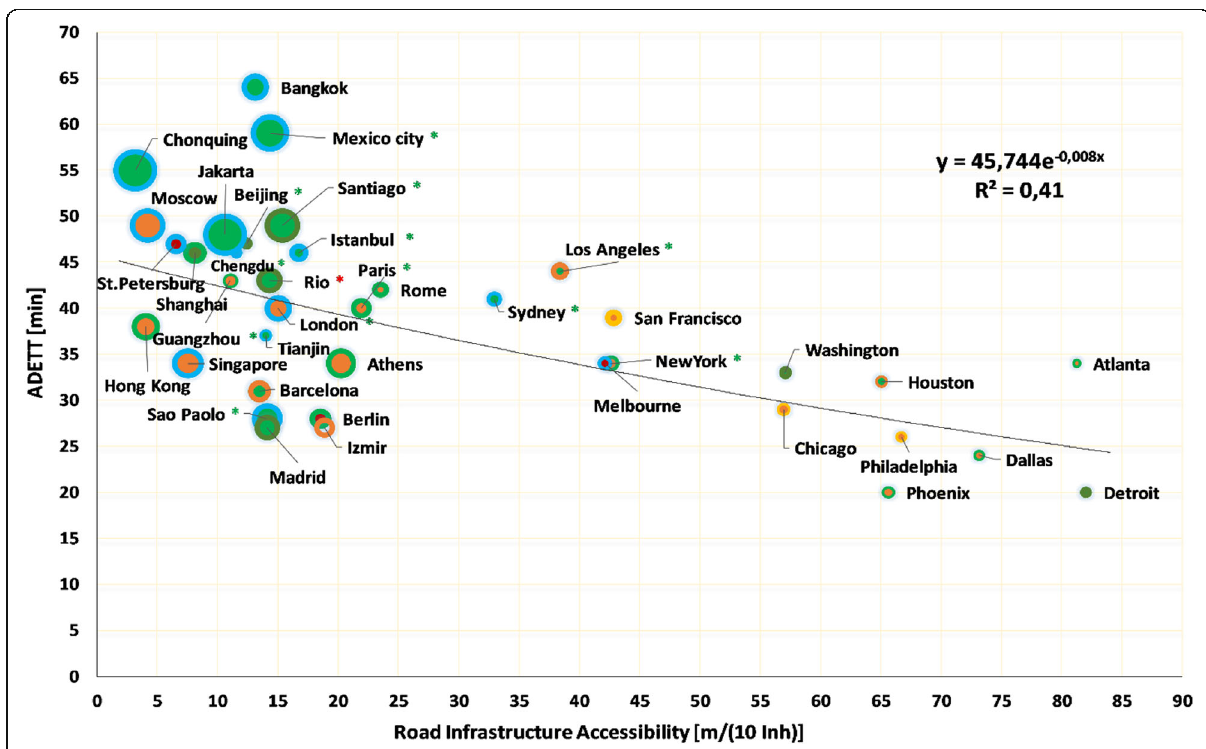
Fig. 2 Multi variant diagram of metropolises. Congestion level (ADETT) over Road IA; Bubble size is proportional to the population density; filled color indicates Train IA, bubble border color indicates Cycle IA, color of starred city- labels indicate BRT IA. For color scaling, see Table.5. The dotted line represents the fitted exponential curve from